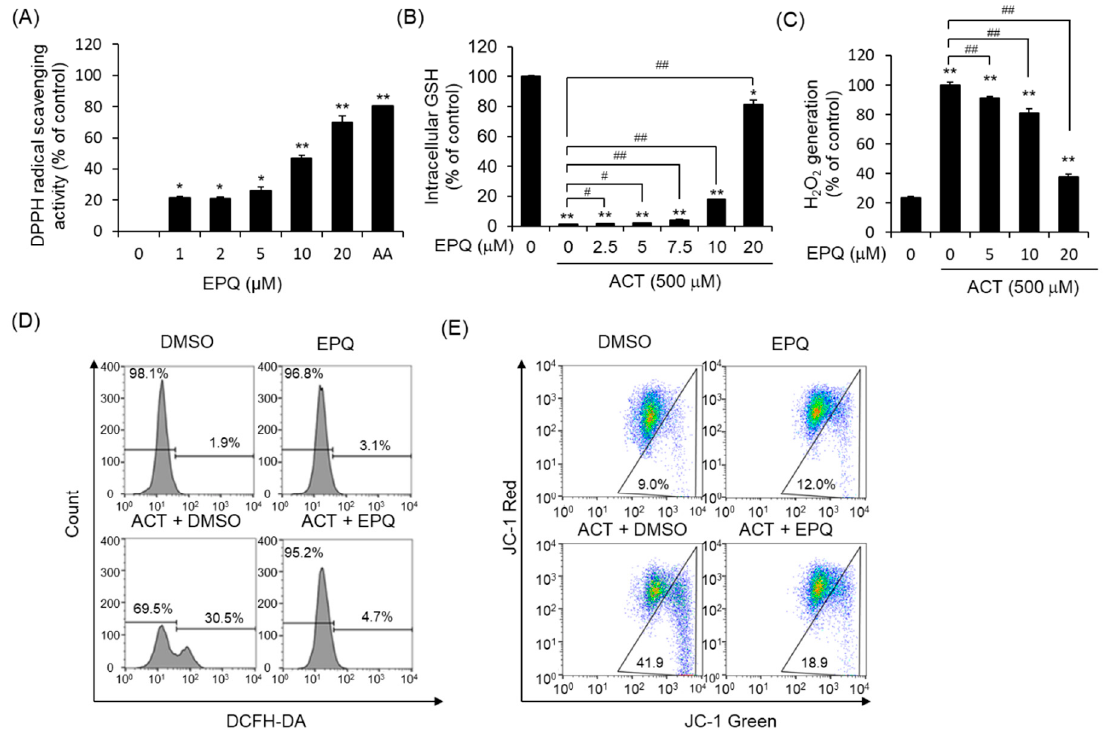
Figure 3. Inhibitory effects of EPQ on acetaldehyde-induced oxidative stress in PC12 cells. ( A ) The radical-scavenging activity of EPQ was measured using the DPPH assay. Cells were seeded in a 96-well plate and treated with various concentrations of EPQ for 24 h. AA (1 mM) was used as a positive control. All values are expressed as mean ± SEM ( n = 3; * p < 0.05, ** p < 0.01 compared to the DMSO control group). ( B ) Intracellular GSH activity was measured using the GSH-Glo assay. Cells were treated with various concentrations of EPQ in the presence and absence of acetaldehyde (500 µ M) for 24 h. All values are expressed as mean ± standard error ( n = 3; ** p < 0.01 compared to the DMSO control group and # p < 0.05 compared to the group treated only with ACT). ( C ) H 2 O 2 production was measured using the ROS-Glo H 2 O 2 assay. Cells were treated with various concentrations of EPQ in the presence and absence of acetaldehyde (500 µ M) for 24 h. All values are expressed as mean ± SEM ( n = 3; ** p < 0.01 compared to the DMSO control group and ## p < 0.01 compared to the group treated only with ACT). ( D ) The intensity of fluorescence of cells stained with DCFH-DA was analyzed using flow cytometry. Cells were treated with DMSO (0.5%, v / v ) or EPQ (20 µ M) in the presence and absence of acetaldehyde (500 µ M) for 24 h. ( E ) Mitochondrial membrane potentials were detected using JC-1 staining and analyzed using flow cytometry. Cells were treated with DMSO (0.5%, v / v ) or EPQ (20 µ M) in the presence and absence of acetaldehyde (500 µ M) for 24 h. ACT, acetaldehyde; EPQ, ent -peniciherqueinone; DMSO, dimethyl sulfoxide; AA, ascorbic acid; GSH, glutathione.